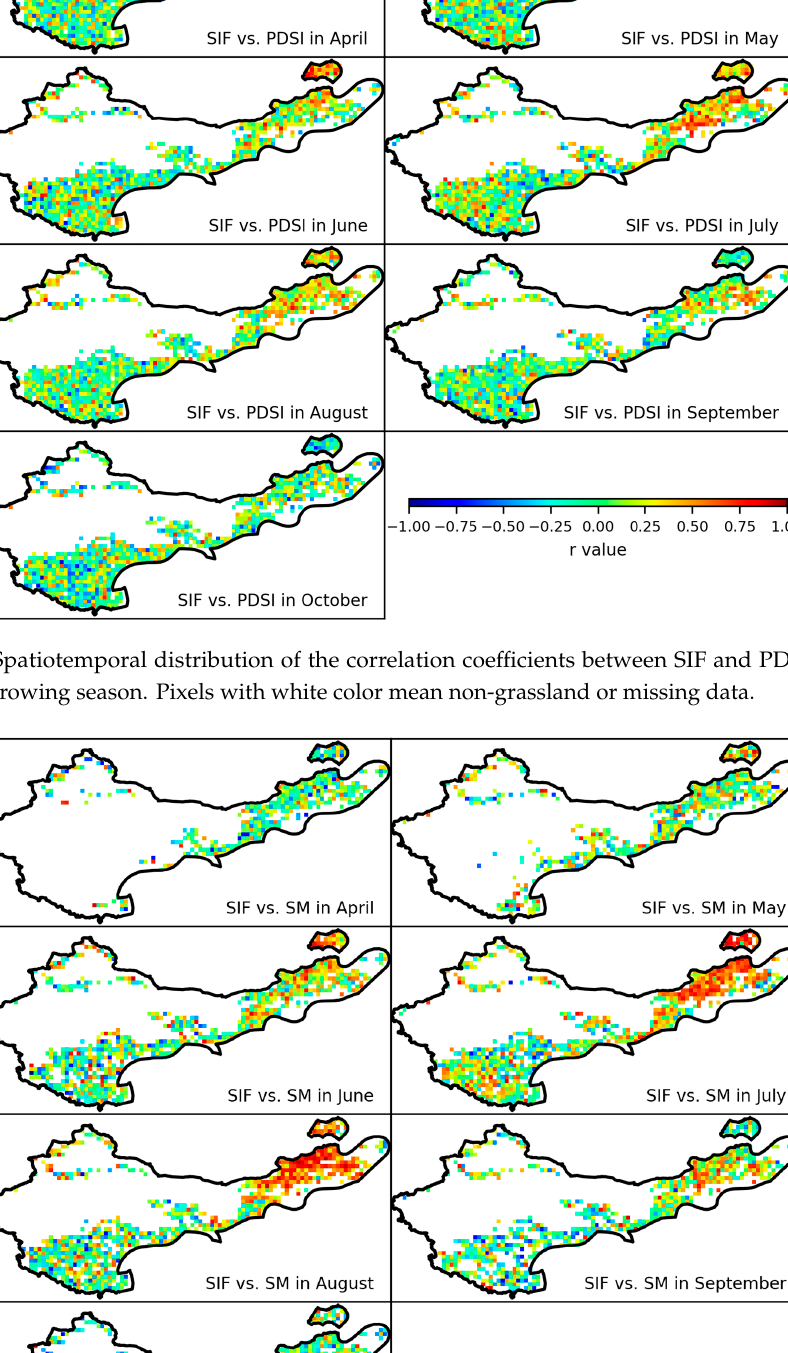
Figure 7. Spatiotemporal distribution of the correlation coefficients between SIF and TCI in each month of growing season. Pixels with white color mean non-grassland or missing data.